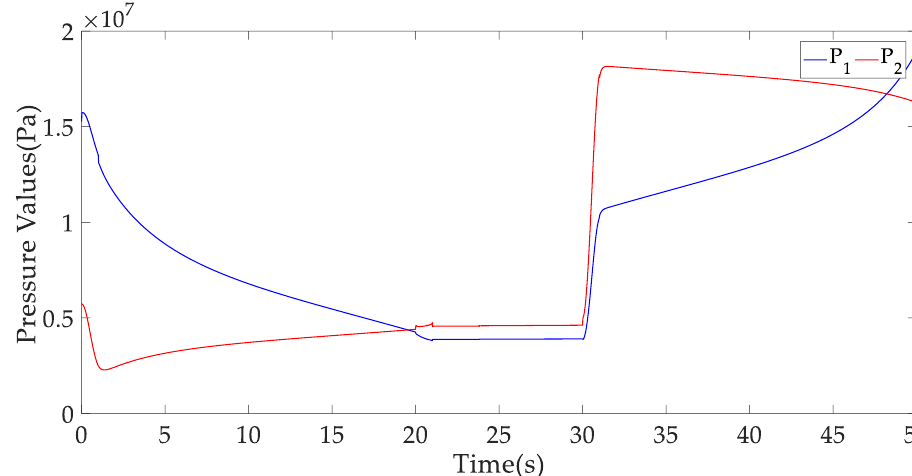
Figure 11. The pressure values of two chambers in NRC.